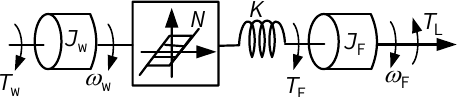
Figure 2. A schematic diagram of the mechanical structure of the two-mass wind drivetrain.